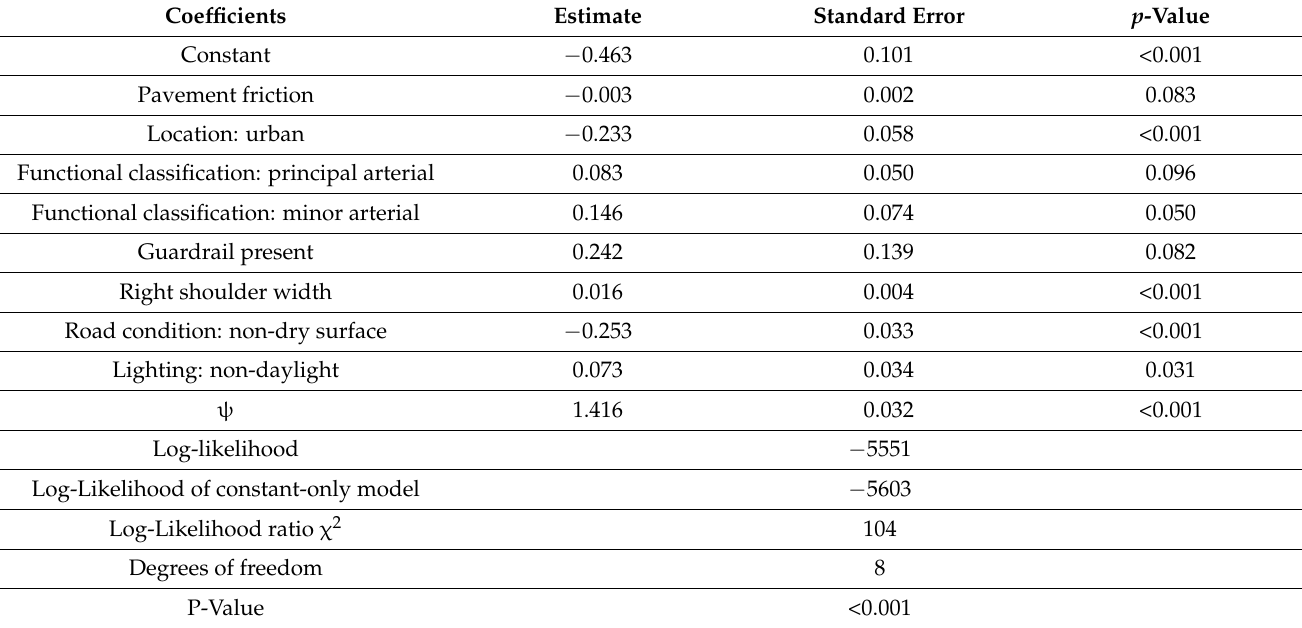
Table 2. Ordinal probit model